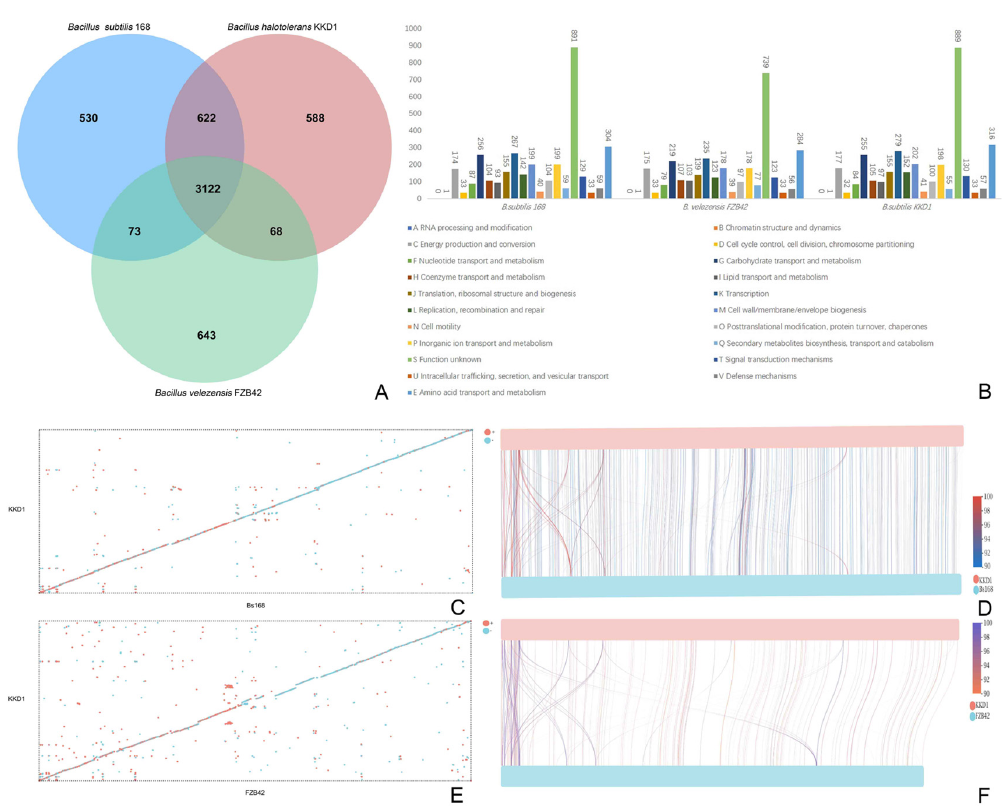
Figure 3. Comparative genomic analysis of KKD1 with model Bacillus strains. ( A ) Each strain is represented by an oval. The number of orthologous genes shared by all strains ( B. halotolerans KKD1, B. velezensis FZB42 and B. subtilis 168) is in the center. Numbers in nonoverlapping portions of each oval show the number of CDSs unique to each strain. ( B ) Genome analysis of the three strains based on the COG database. ( C ) A dot plot of the collinearity analysis between B. halotolerans KKD1 and B. subtilis 168. The abscissa represents B. subtilis 168, and the ordinate represents B. halotolerans KKD1. ( D ) The line graph of collinearity analysis between B. halotolerans KKD1 and B. subtilis 168. ( E ) A dot plot of collinearity analysis between B. halotolerans KKD1 and B. velezensis FZB42. The abscissa represents B. velezensis FZB42, and the ordinate repre- sents B. halotolerans KKD1. ( F ) The line graph of collinearity analysis between B. halotolerans KKD1 and B. velezensis FZB42. Note: The blue dots in ( C , E ) represent the forward comparison of two strains, the composition and direction of the se- quences are the same, and the red dots represent the reverse comparison of two samples. The sequence composition is the same, and the direction is opposite. Different colors in ( D , F ) indicate different regions in the samples, and the color and width of the color band indicate the alignment length and the region homology.